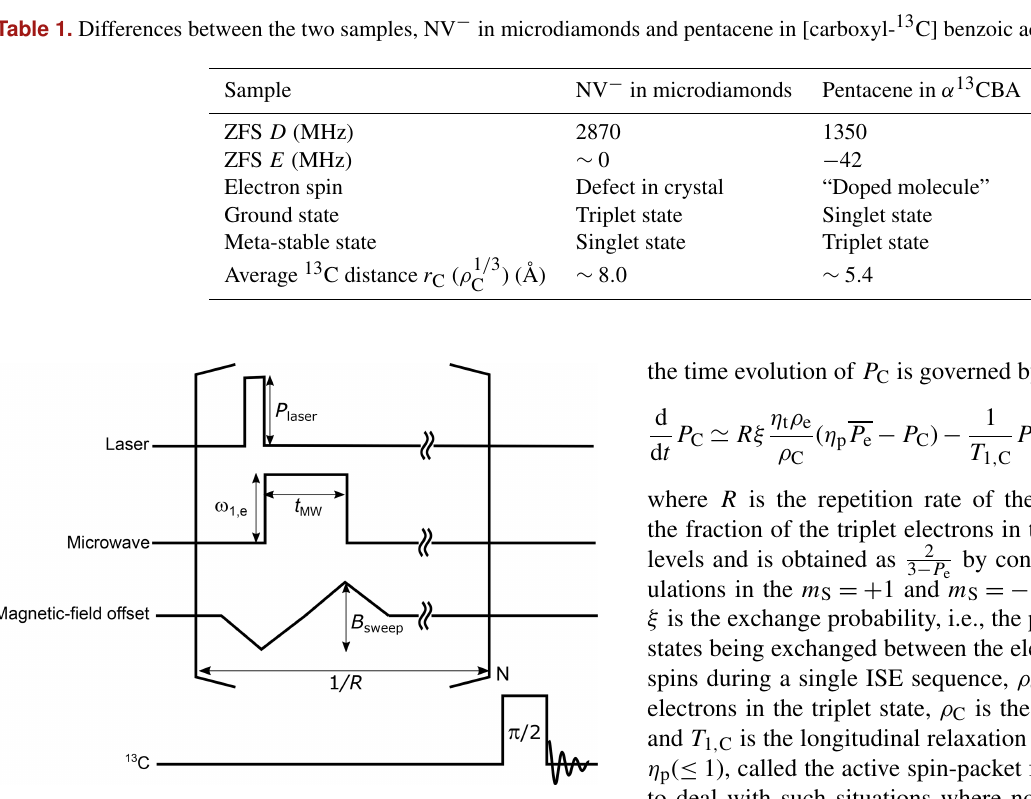
Figure 2. The pulse sequence for the ISE followed by NMR de- tection. A laser pulse is used for photoexcitation and optical polar- ization of the triplet electron spins. Then, a microwave pulse is ap- plied together with a magnetic-field sweep. The ISE pulse sequence is repeated before the enhanced 13 C magnetization is detected by applying a radiofrequency π /2 pulse. During the acquisition of the 13 C signal, 1 H decoupling is to be applied in the case of the benzoic acid sample. The definitions of the symbols used in the figure are as follows. P laser : laser-beam intensity, ω 1 , e : microwave intensity, t MW : microwave-pulse width, B sweep : field-sweep width, R : ISE repetition rate, and N : ISE repetition